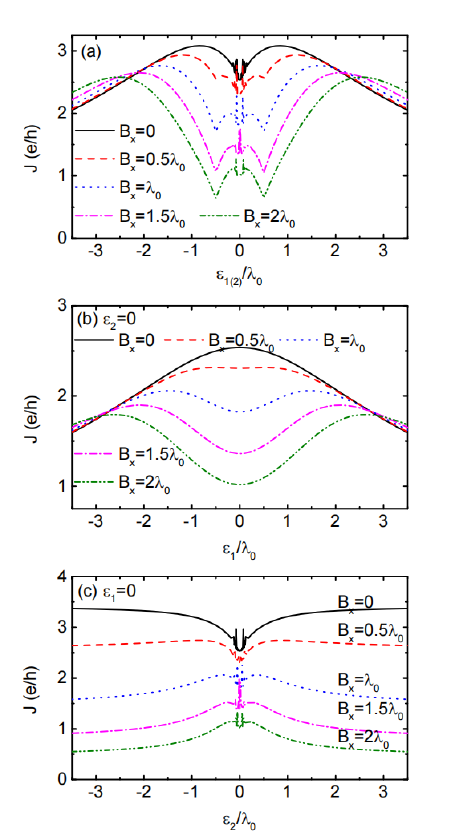
Figure 6. (Color online) Effects of the junction bending on the Josephson current varying with respective to ε 1 = ε 2 in ( a ), ε 1 in ( b ) for ε 2 = 0, and ε 2 in ( c ) for ε 1 = 0. Other parameters are ∆ φ = π /2, t c = λ 0 /2 and θ = δ M =